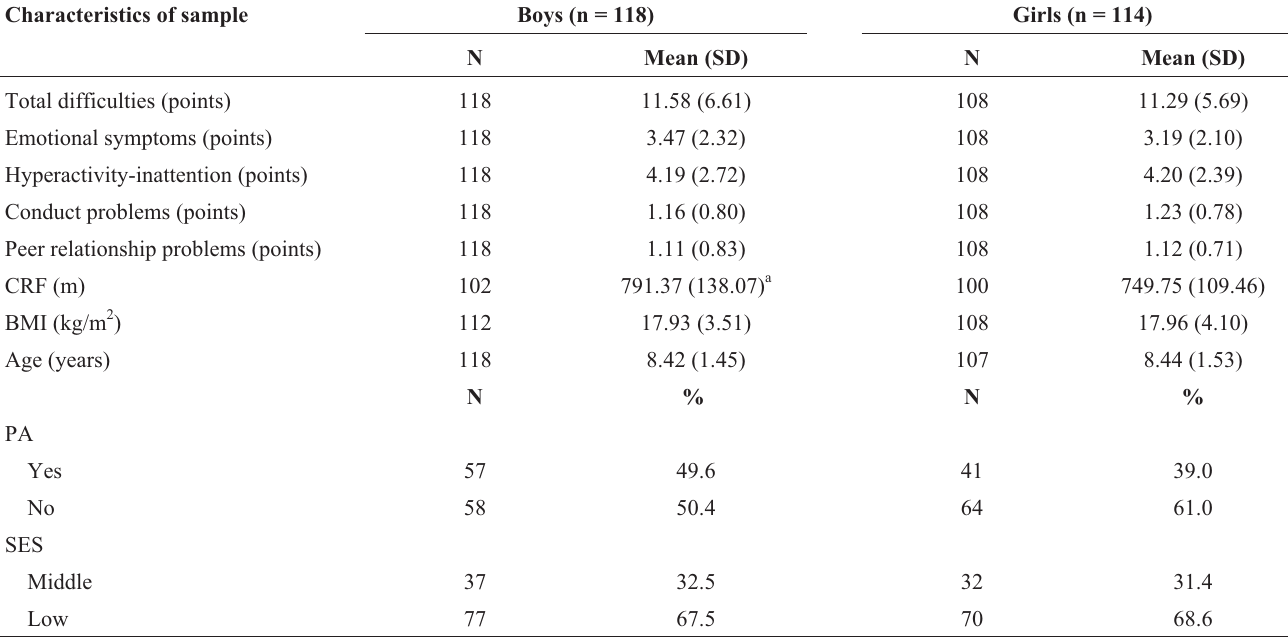
Table 1 - Descriptive characteristics of sample, separated by sex. Characteristics of